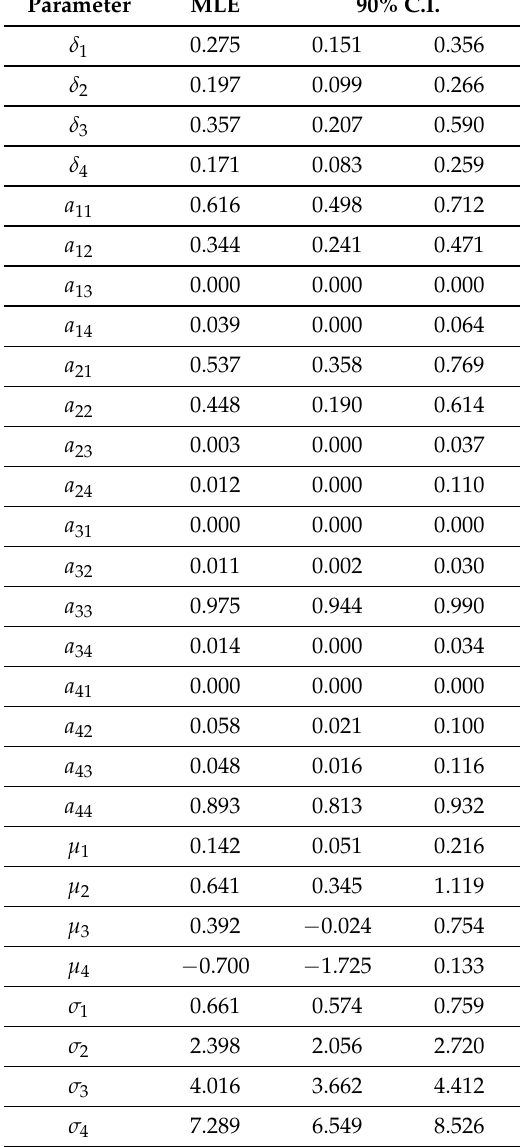
Table 2. Parameter estimates and parametric bootstrap confidence intervals for the stationary four-state HMM based on the complete BTC/USD log returns series.